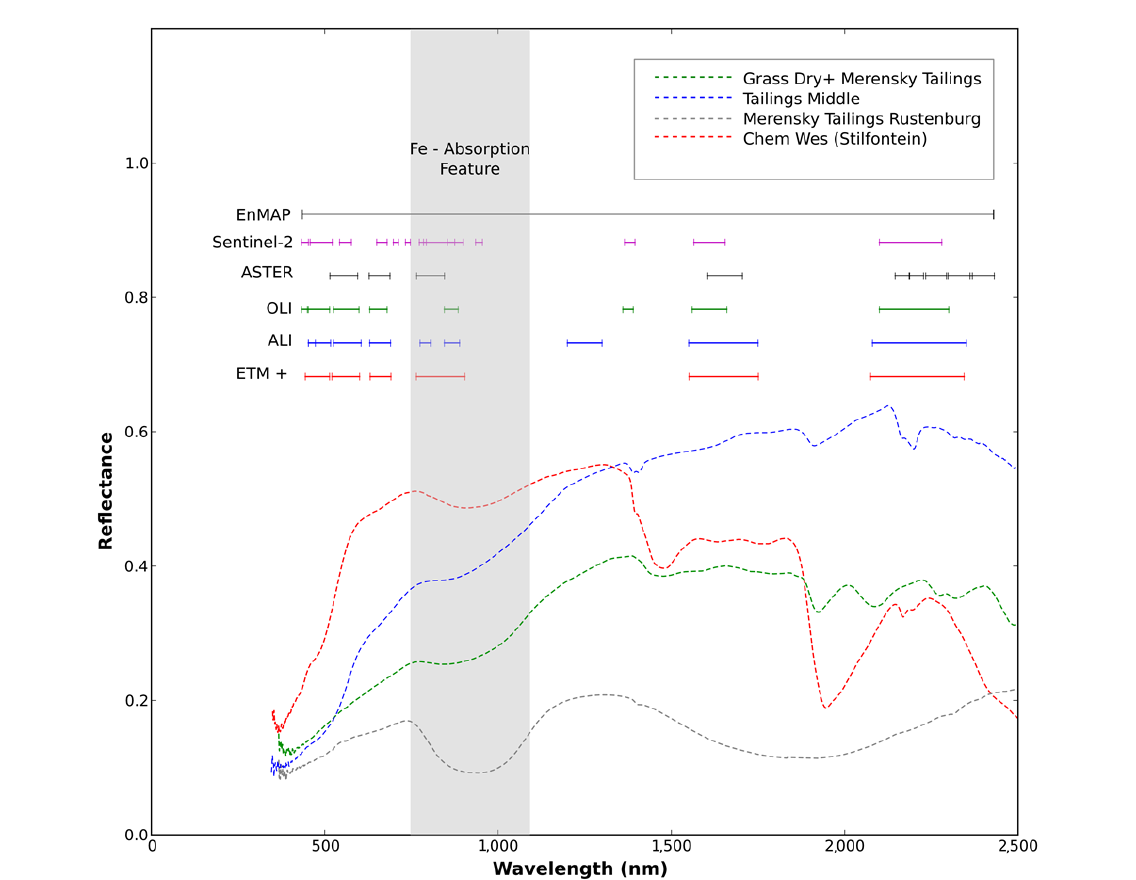
Figure 4. Band positions of selected multispectral sensor systems overlain on field spectra from the mine waste sites in South Africa. Continuous data coverage of EnMAP are shown for reference. Note the position of the near-infrared channels of the multispectral sensor systems within the broad iron absorption feature at 900